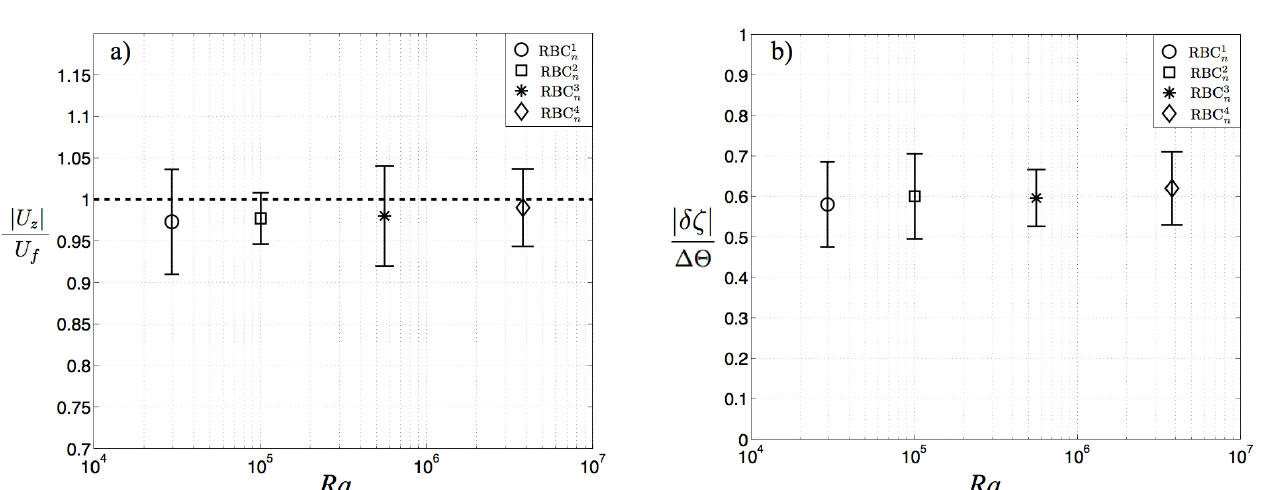
; n ) (cid:105) for the i t ) (cid:105) ). i t